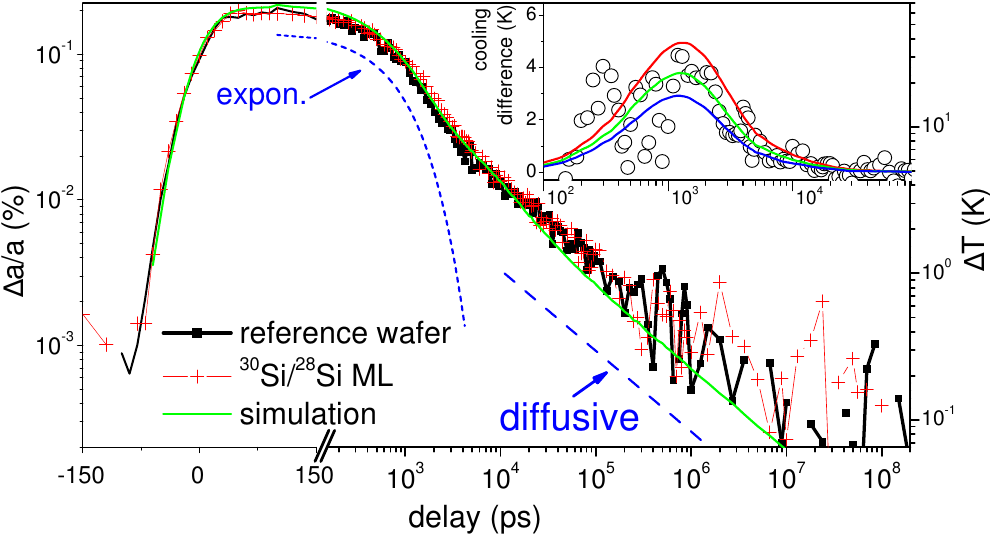
Figure 5. Lattice expansion of the gold layer on top of two silicon samples, the reference substrate (black squares) and the wafer with the isotope-modulated multilayer stack (red crosses). The lines are a guide to exponential and diffusive decay, respectively simulations of temperature decay based on the layer model in conductivity. The shape around τ = 0 is modeled by a sigmoidal function with 30 ps Gaussian width. The inset displays the change in cooling of the 30 Si/ 28 Si-ML compared to the native Si reference sample. The lines are simulations by assuming a change of thermal conductivity to 55 (red), 60 (green) and 65 (blue) W/(m · K), from